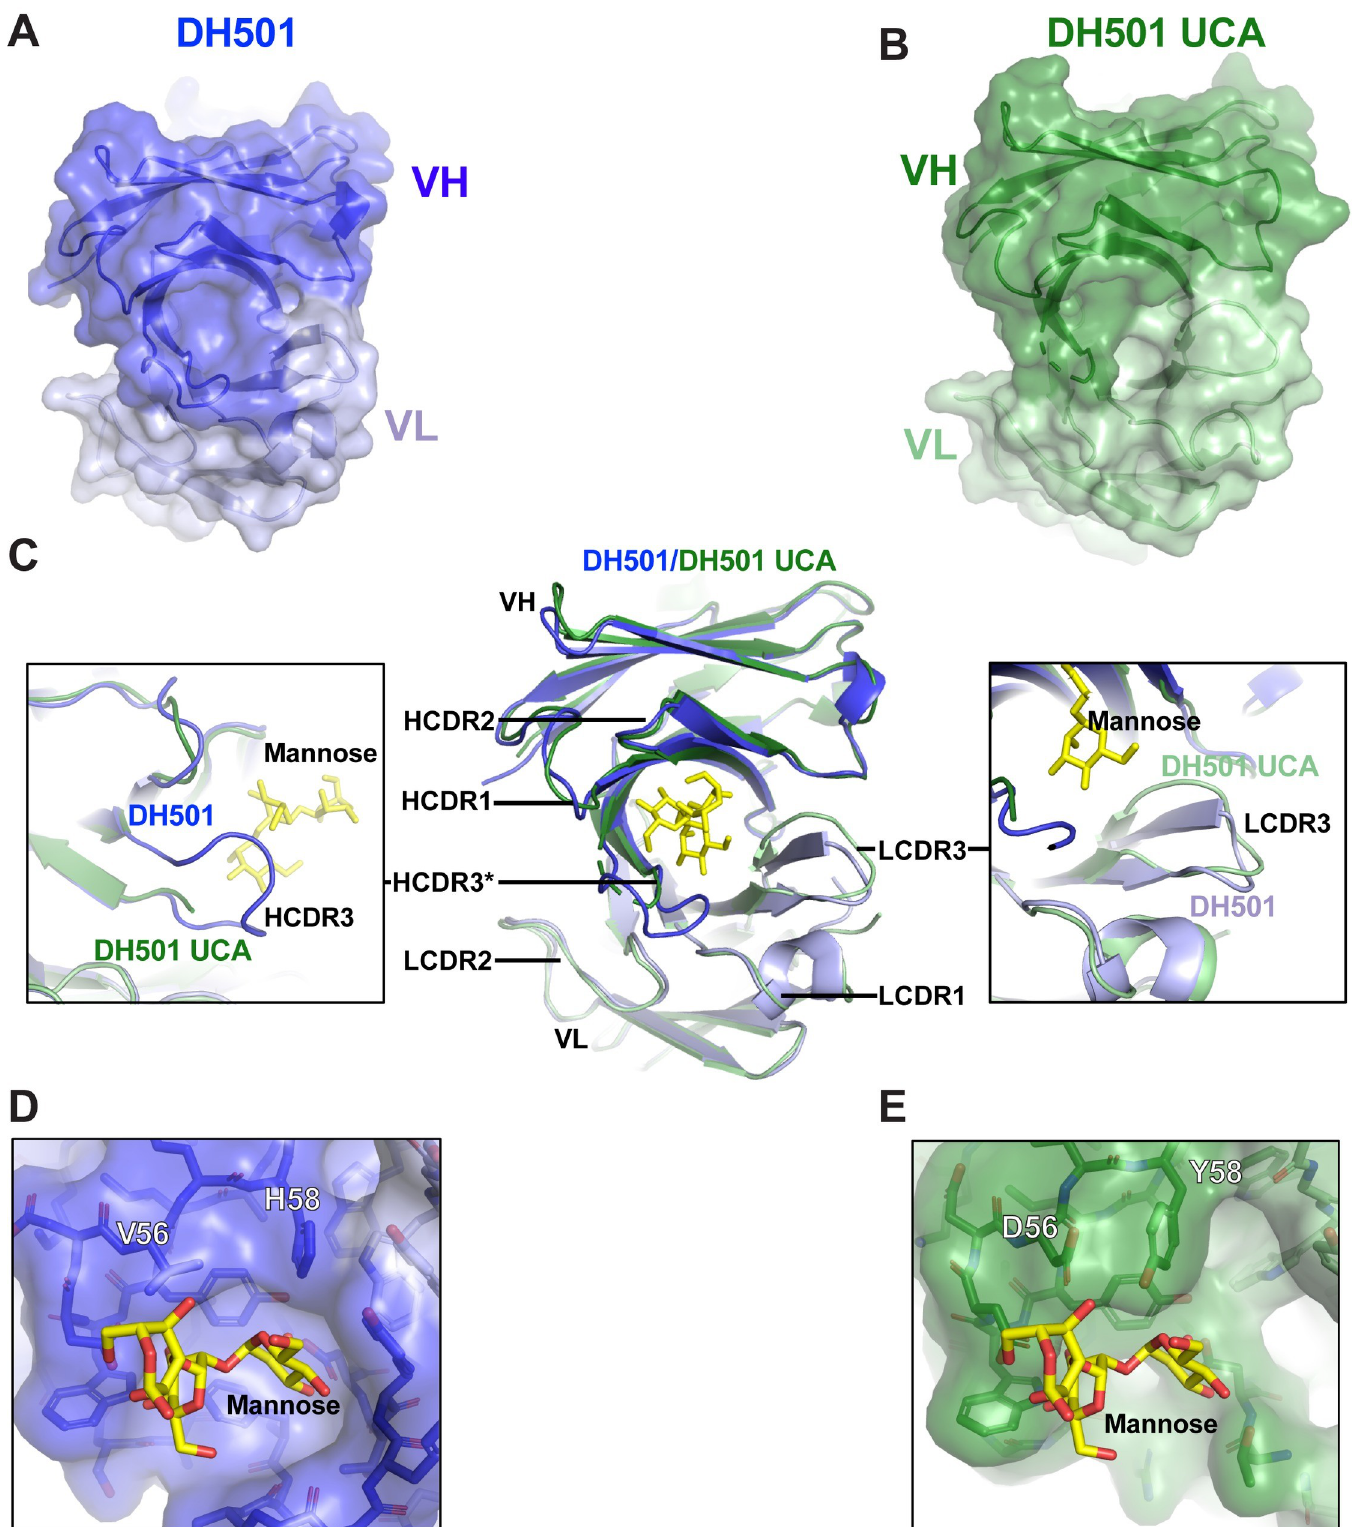
Fig 2. The crystal structure of the DH501 UCA. ( A,B ) Top view of the crystal structures of ( A ) DH501 (blue; PDB: 5T4Z) and the inferred ( B ) DH501 UCA (green; PDB: 6P3B). The variable region of the heavy chain (V H ) is shown in dark colors and the variable region of the light chain (V L ) is shown in the light color. Portions of the